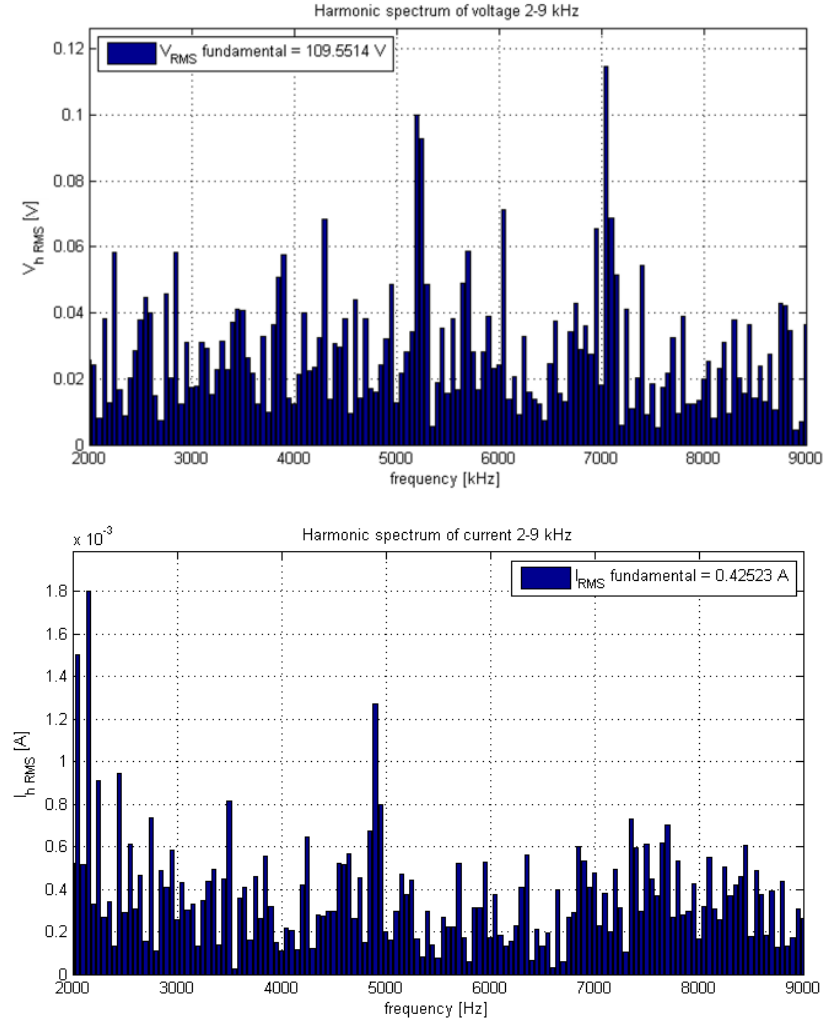
Figure 5. Harmonic decompositions of voltage and current in the range (2 – 9) kHz: ( top ) — volage; ( down ) —